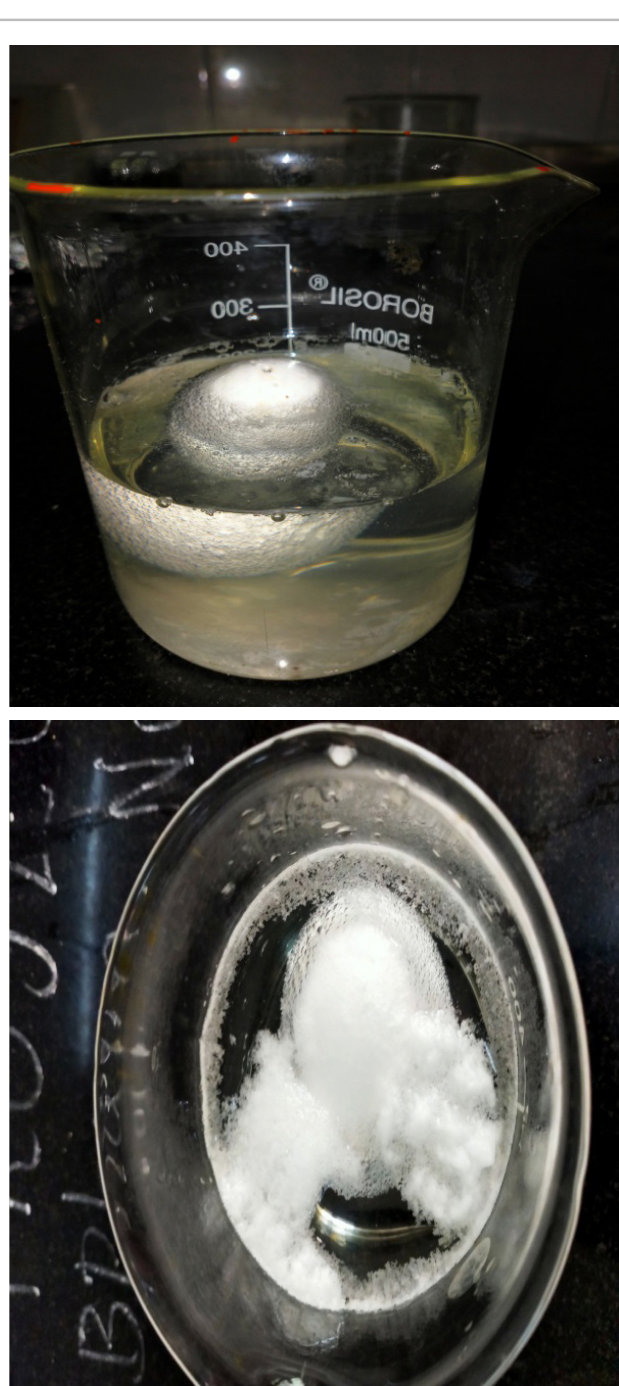
FIGURE 1(a) & 1(b) - Process of Decalcification of